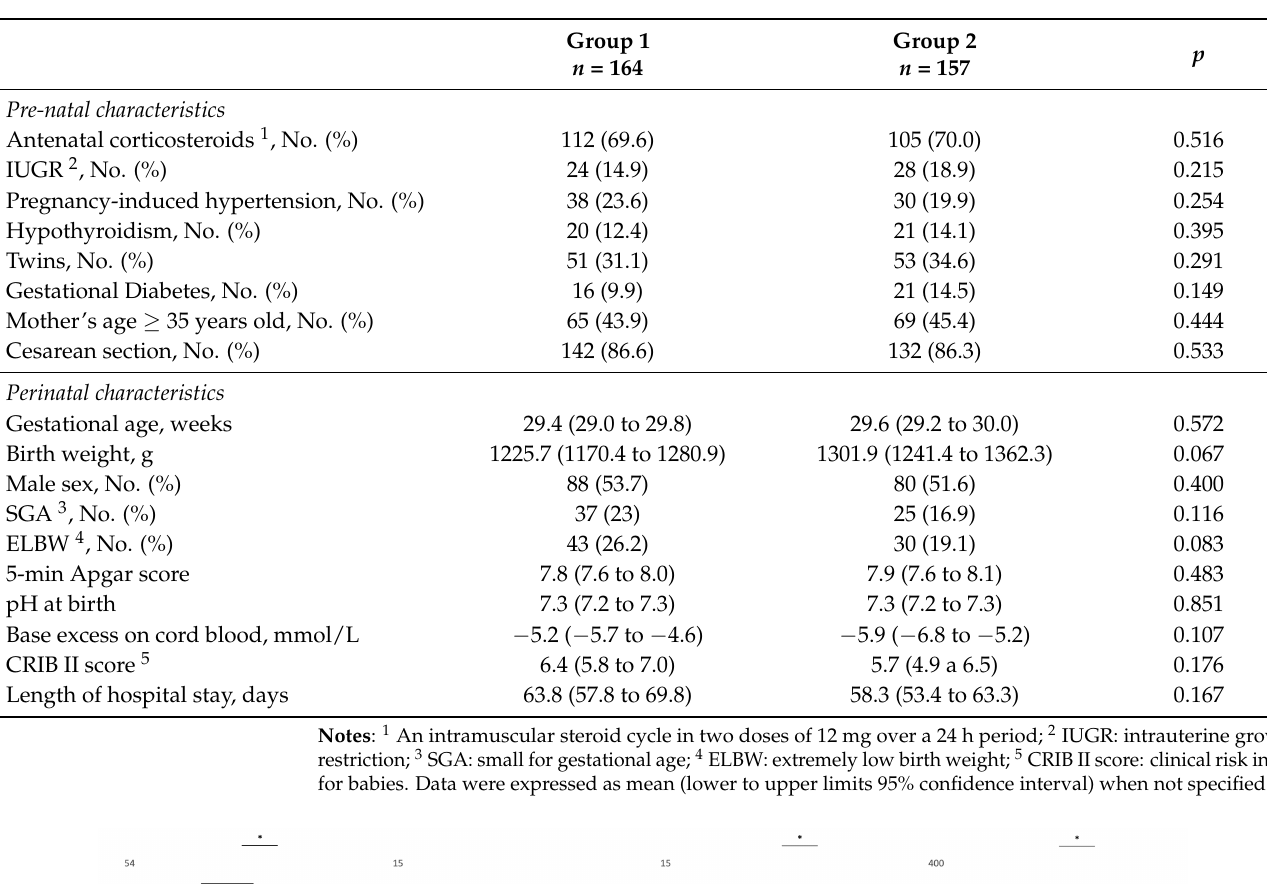
Table 2. Baseline clinical characteristics of neonates enrolled in the study.